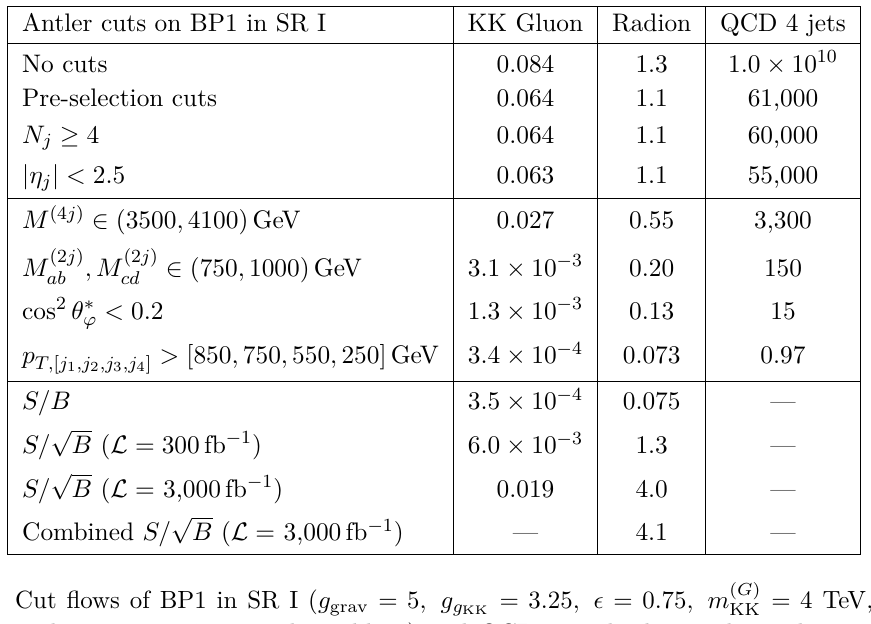
Table 2 . Cut flows of BP1 in SR I ( g grav = 5 , g g 3 . 75 TeV , and m ϕ = 1 TeV , see also table 1) and QCD 4-jet backgrounds at the 14 TeV LHC with cuts designed for the antler topology. The values of cross-sections are in fb. The reported no-cut cross-sections in the second and the third columns are the production cross-section of KK graviton multiplied by the associated branching fractions. The pre-selection cuts are p [600 , 400 , 200 , 100] GeV, ∆ R jj > 0 . 4 , and | η j | < 4 . For the dijet invariant mass window cut, we test whether (at least) a pair of dijet invariant mass values out of three possible pairings satisfy the condition.